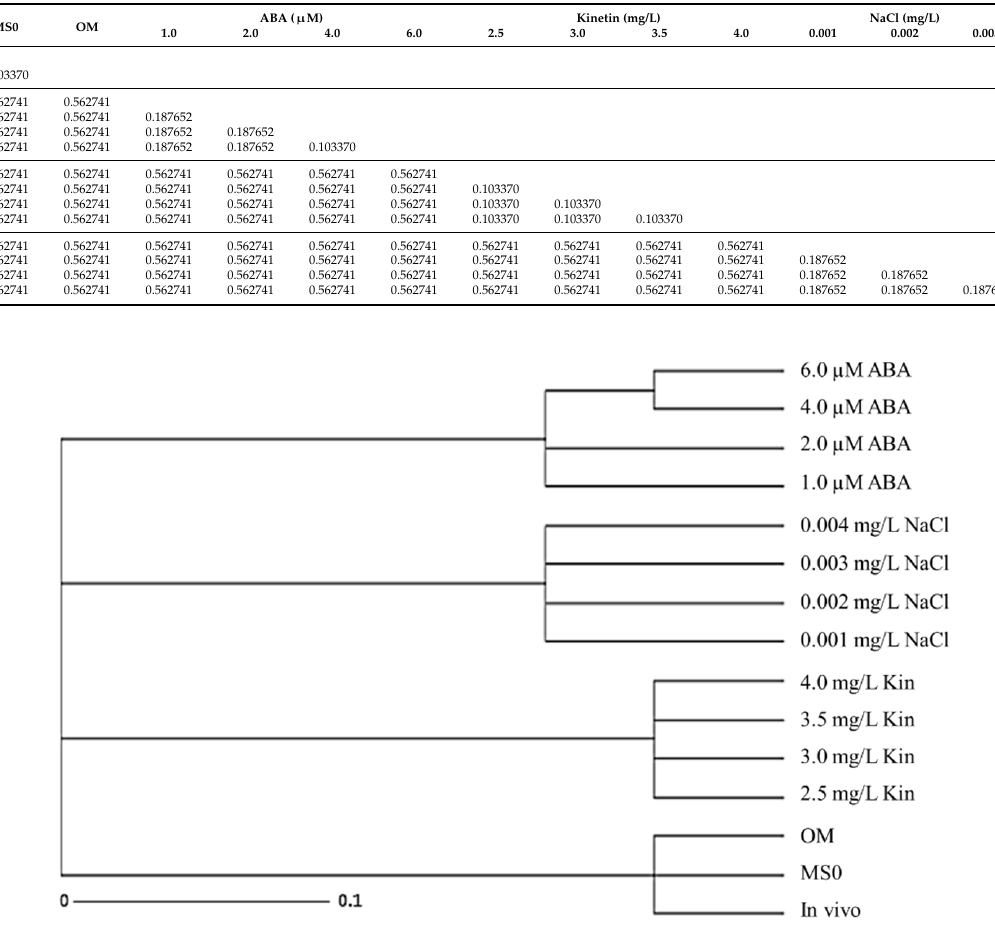
Table 8. Genetic distance based on Jaccard’s distance coefficient for in vitro grown O. stamineus plantlets exposed to abiotic stress.